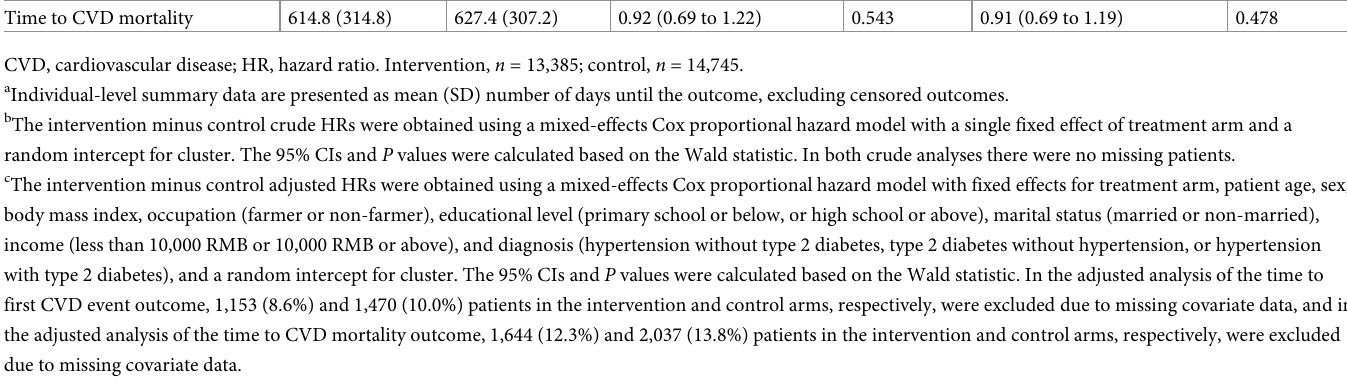
Outcome Mean (SD) number of days a Crude HR (95% CI) b Intervention Control Time to the first CVD